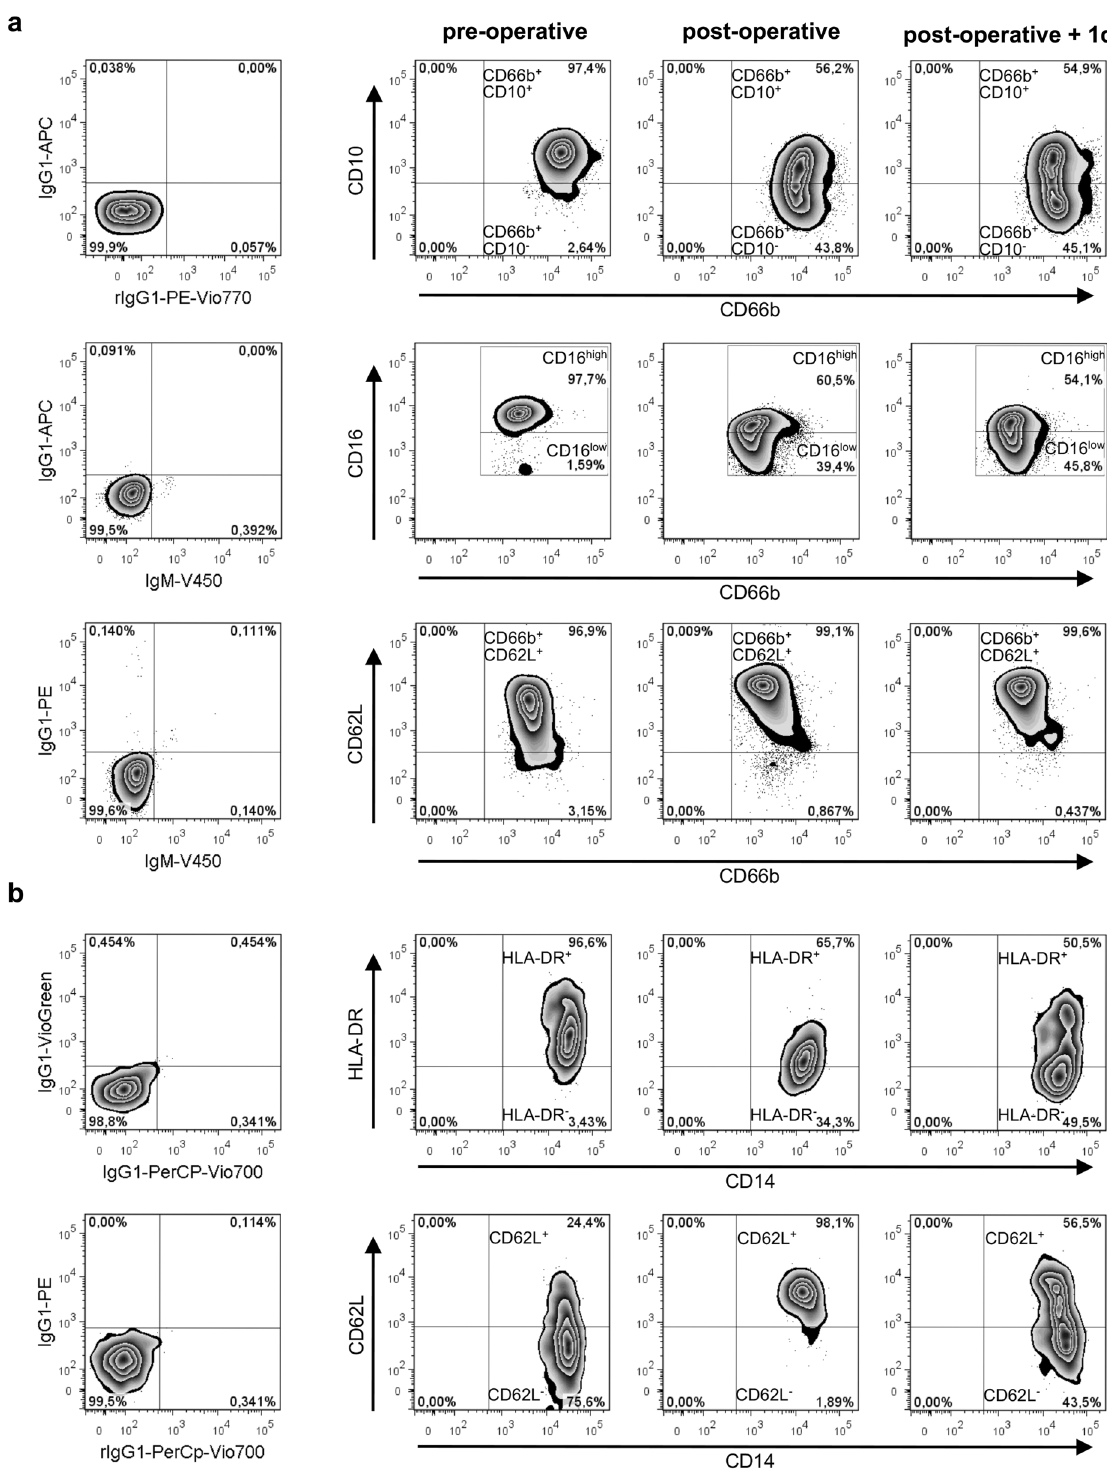
Figure 3. Surface phenotypes of monocytes and neutrophils after surgery indicate an increased number of immature cells in blood of HLM patients. Flow cytometry analysis of CD66b + neutrophils ( a ) and CD14 + monocytes ( b ) from whole blood of HLM patients taken before cardiac surgery (pre-operative), immediately after surgery (post-operative) and one day after admission to intensive care (post-operative + 1d) are shown. ( a ) Immature phenotype of CD66b + blood neutrophils was analyzed by surface expression of CD10, CD16 and CD62L. Representative zebra plots show a change of the surface phenotype by the shift of the population to the lower right quadrant for CD10 and CD16 and to the higher right quadrant for CD62L. ( b ) Surgery-induced changes on CD14 + blood monocytes are represented by zebra plots of HLA-DR and CD62L expression patterns. Left plots show proper gate setting defined by isotype control